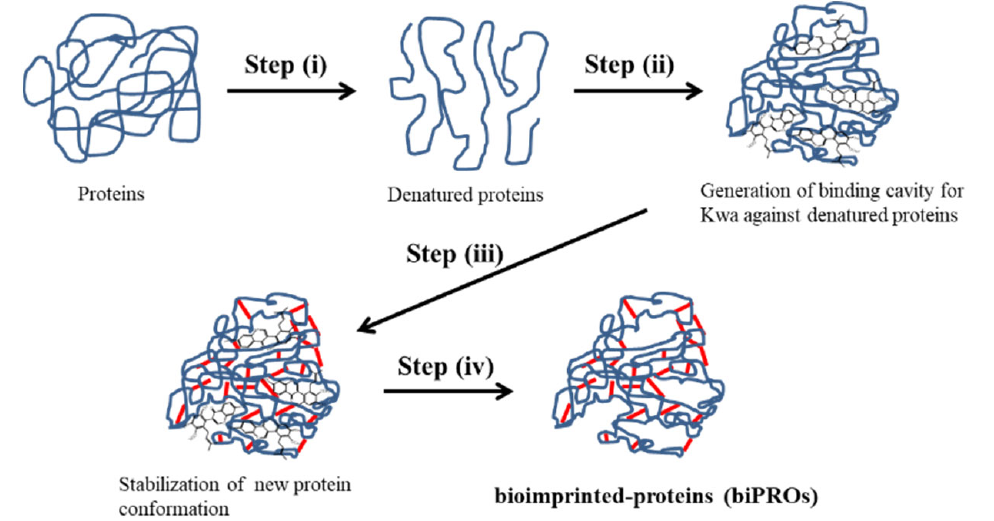
Figure 1. Schematic diagrams of bioimprinting process for Kwa. (i) Proteins are denatured under acidic conditions, and (ii) Kwa is added to the denatured protein for their interaction to generate binding cavity. Subsequently, (iii) denatured proteins are crosslinked with a bifunctional reagent to stabilize the new conformation. Finally, (iv) leftover Kwa template is removed by dialysis to obtain bioimprinted-proteins (biPROs) which recognize Kwa.